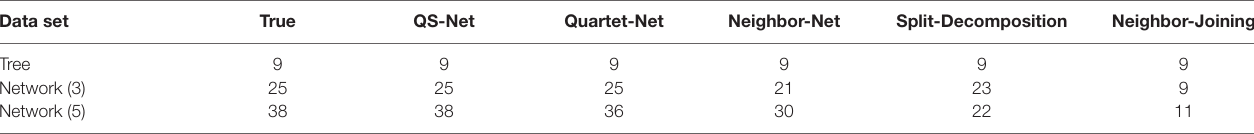
The “True” column represents the real number of true-positive splits of the simulated data.